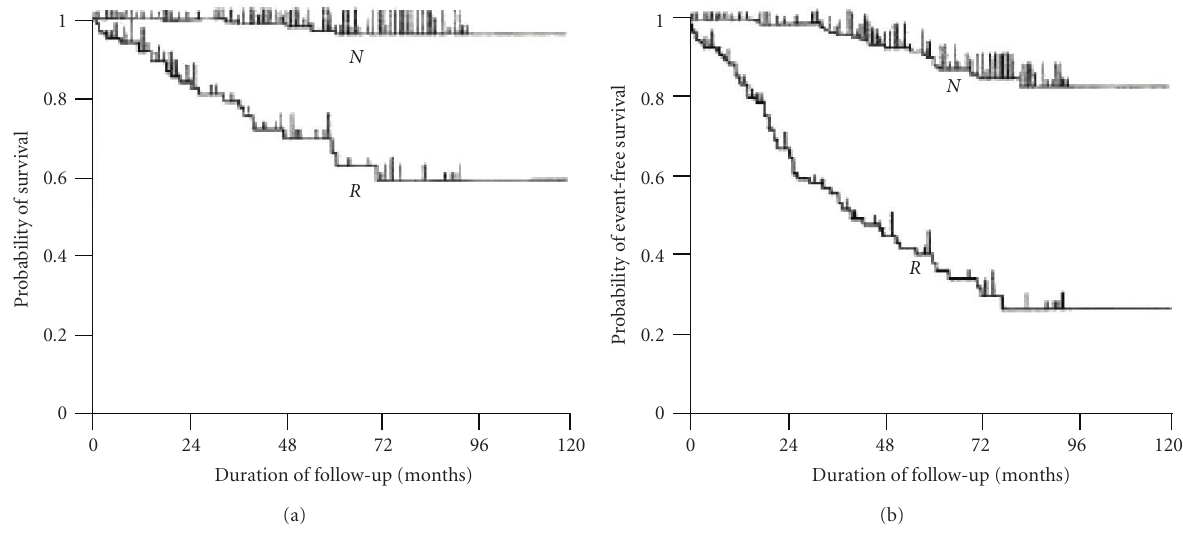
Figure 4: Survival curves (a) and event-free survival curves (b) of diabetic subjects with normal (N) and reversed circadian BP rhythm. The unadjusted relative risk for diabetic subjects with a reversed circadian BP rhythm was 20.6-fold higher than that of subjects with a normal rhythm ( P < . 001; Cox-Mantel’s test) for survival curves (a), and 12.9-fold higher than that of subjects with a normal rhythm ( P < . 001; Cox-Mantel’s test) for event-free survival curves (b) (adopted from [11]).